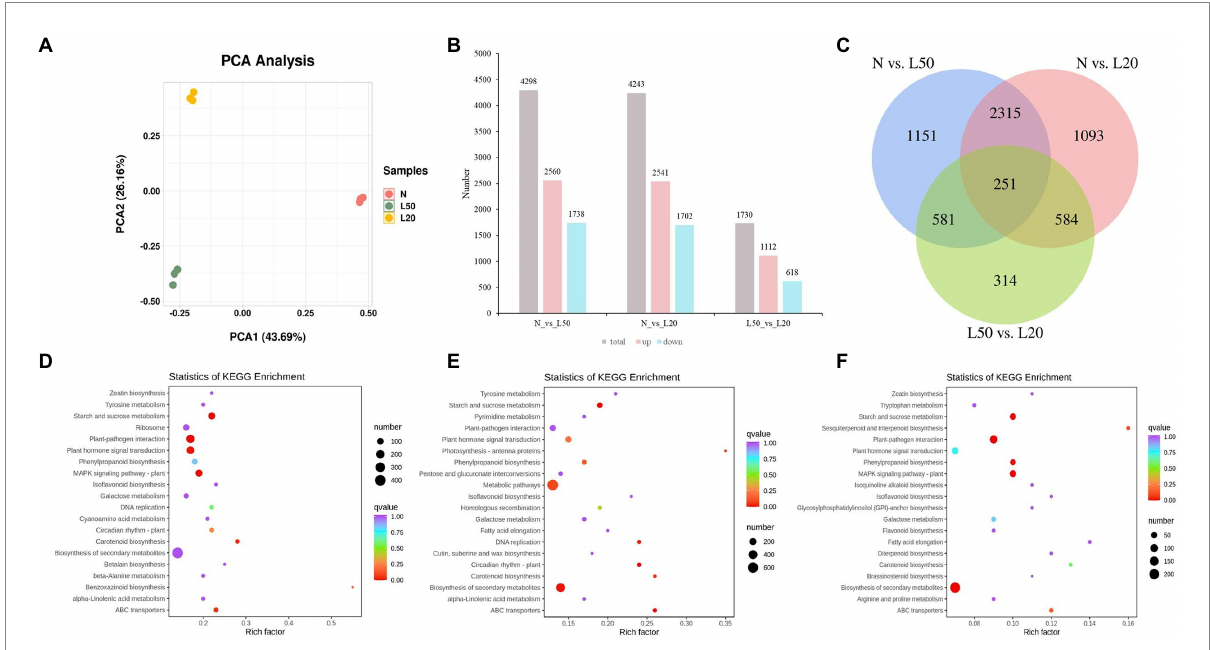
FIGURE 5 Identification and functional enrichment of differentially expressed genes of J. mandshurica under shade. (A) PCA score plot of expression profiles from different samples; (B) The statistics of upregulated and downregulated DEGs in different comparison groups; (C) Venn diagram of DEGs in different comparison groups; (D) The top 20 KEGG enrichment pathways of DEGs in N vs. L50. (E) The top 20 KEGG enrichment pathways of DEGs in N vs. L20. (F) The top 20 KEGG enrichment pathways of DEGs in L50 vs. L20. N: natural sunlight. L50: 50% sunlight to go through. L20: 20% sunlight to go